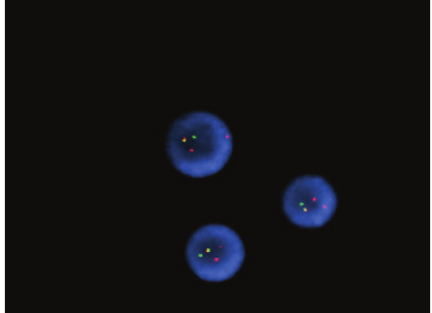
Figure 9: Fluorescent in situ hybridization on original diagnostic bone marrow aspirate shows one BCR-ABL1 fusion signal, two BCR probe signals, and three ABL1 probe signals in 90.5% of interphase